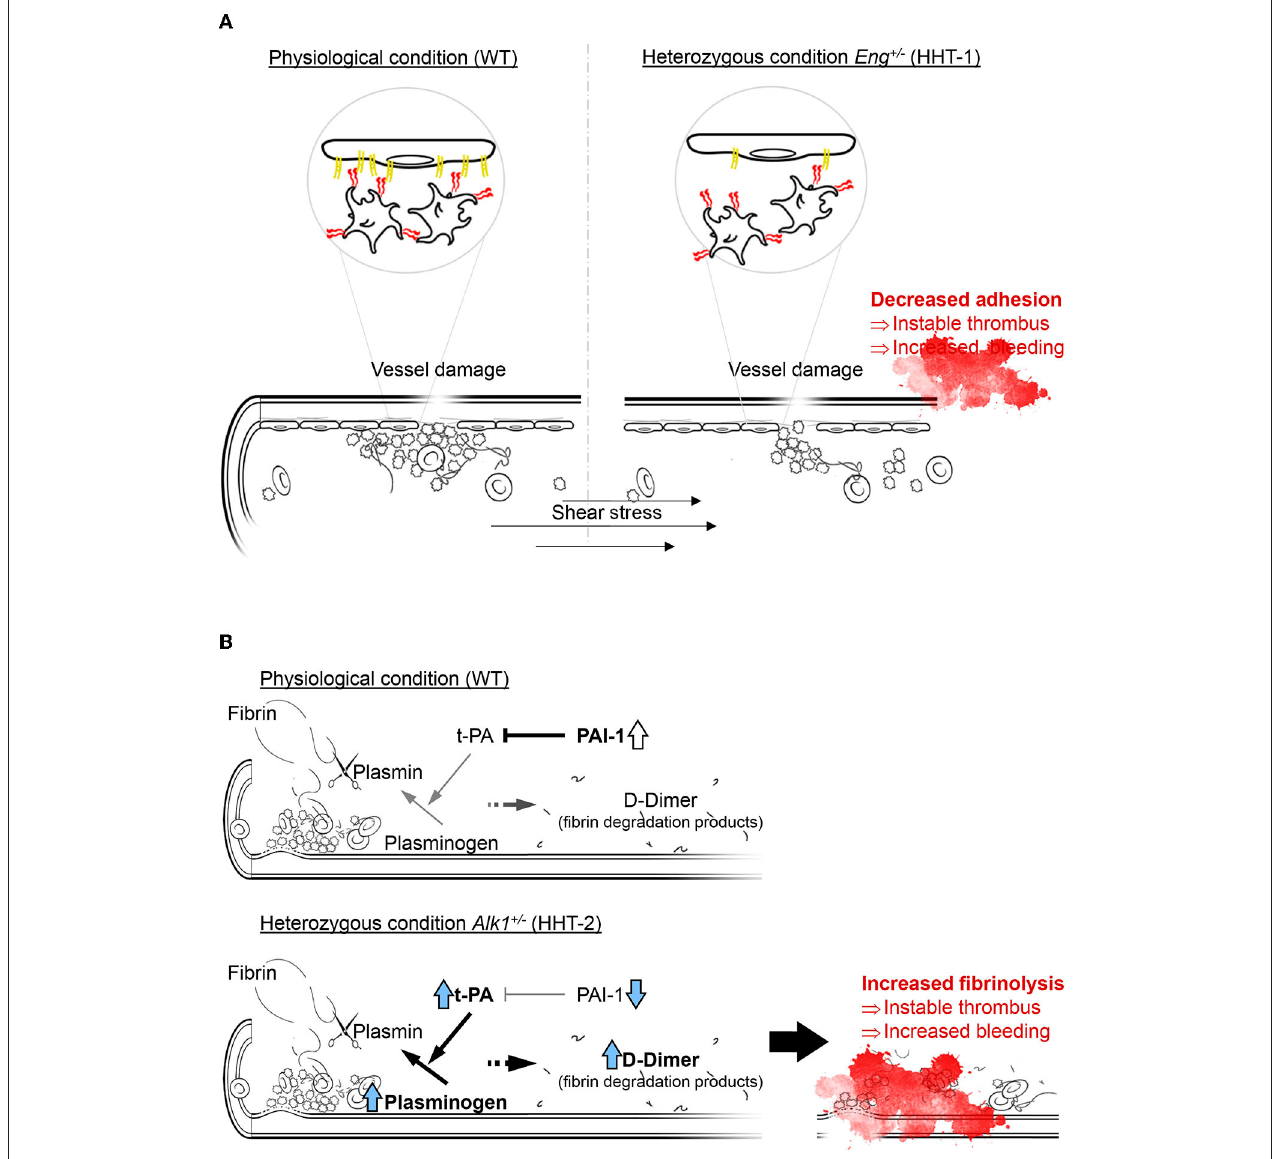
FIGURE 7 | (A) In normal conditions platelets rolling on endothelial cells is effective and the thrombus generated is stable, while a loss on endoglin in the endothelium mean less effective platelets adhesion and an instable thrombus that can be carried away by the bloodstream, compromising thrombosis and increasing bleeding. Thus, endoglin-deficient mice need more time to generate a thrombus large and stable enough not to be entrained. (B) Fibrinolysis depends on the activity of t-PA catalyzing the conversion of plasminogen to plasmin, which is the enzyme responsible for fibrin degradation and thrombus disruption. In physiological conditions, there is an increase in PAI-1 that inhibits the function of t-PA and allows stabilization of the newly formed thrombus. However, ALK1 deficiency causes plasminogen and mainly t-PA levels to be much higher, so that PAI-1 cannot inhibit it and fibrinolysis is increased, which we can detect by the increase in